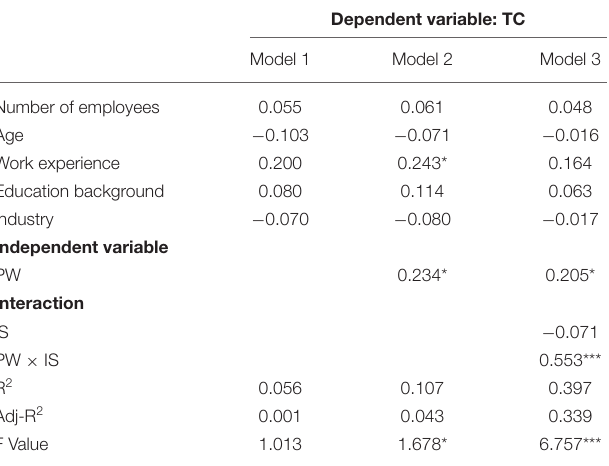
TABLE 3 | The results of linear regression